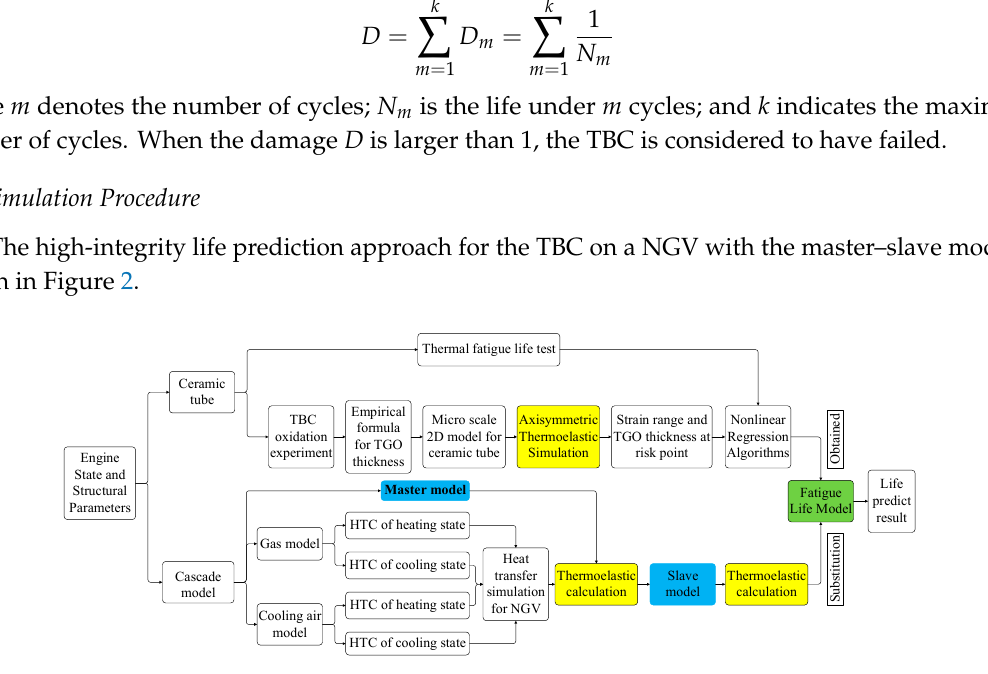
Figure 2. High-integrity life predication approach for the thermal barrier coat (TBC) on NGV.